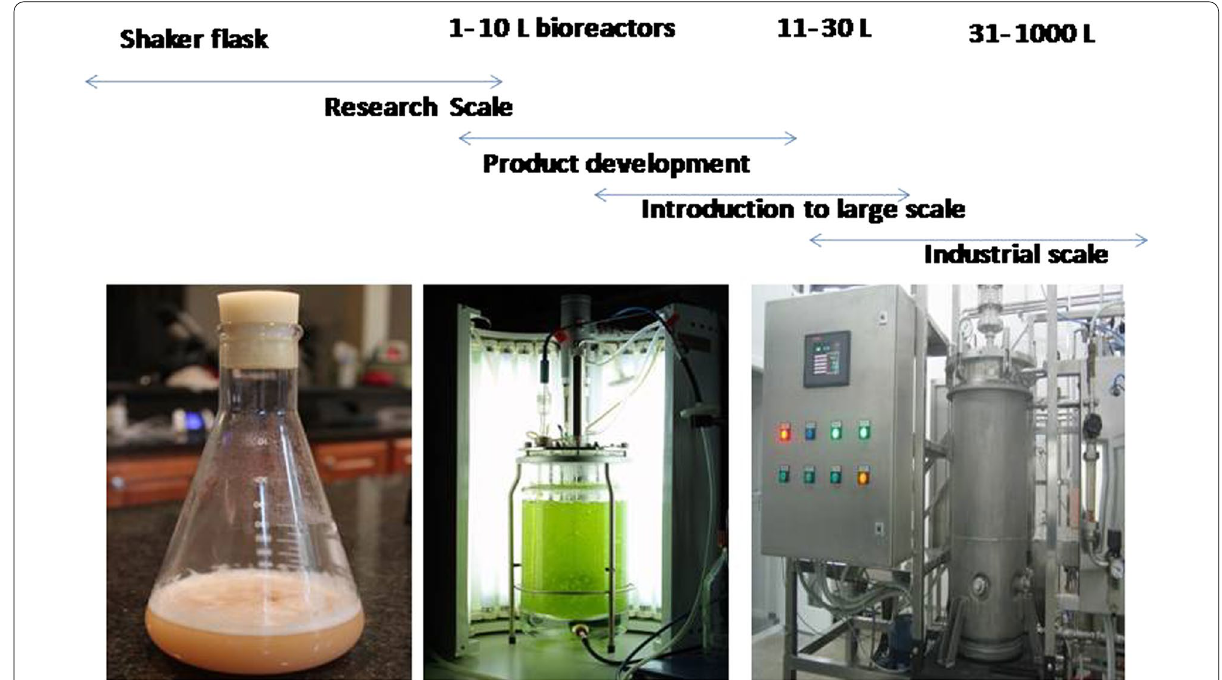
Fig. 5 Scale-up of bioreactors from lab to commercial